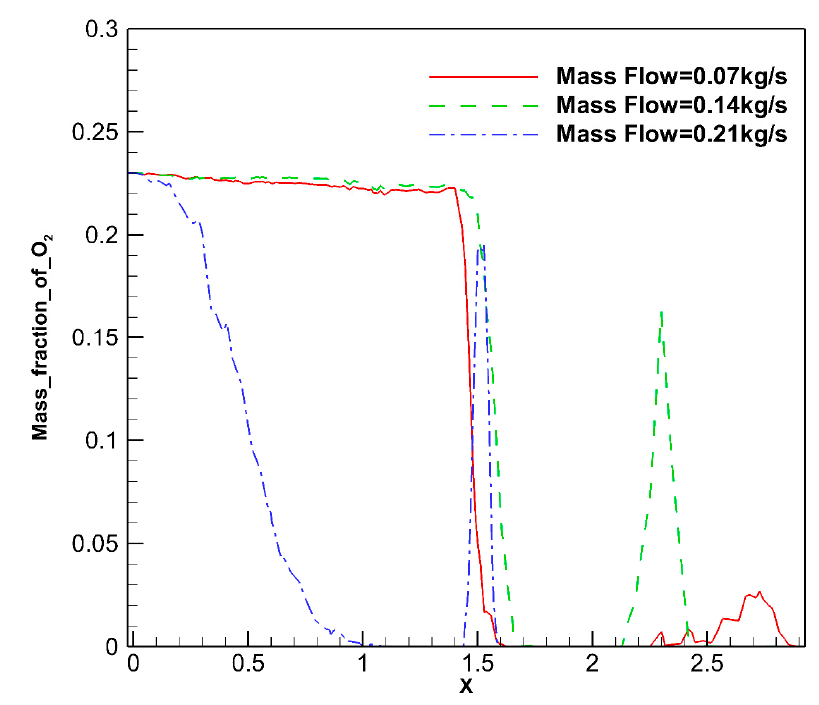
Figure 19. Mass fraction of oxygen on the line at Y = 1.09 m with the rubbish height = 700 mm and the primary burner position = 1500 mm.